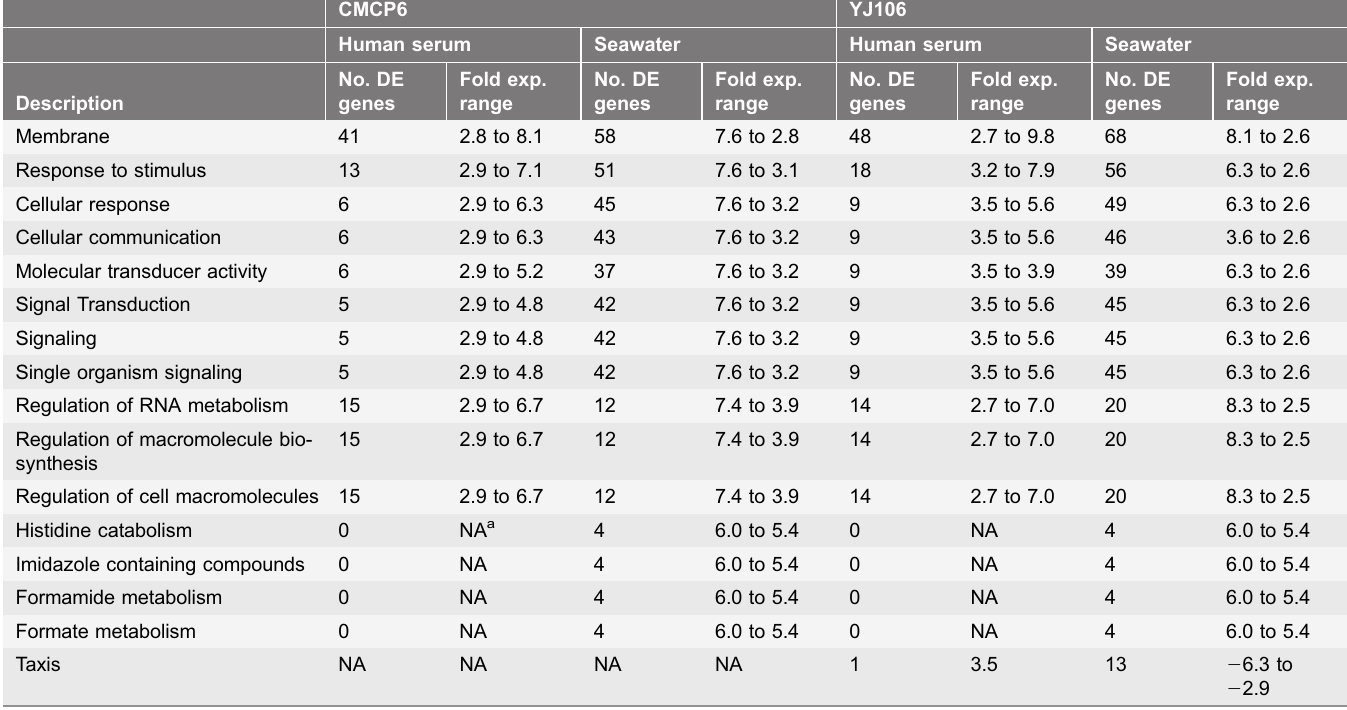
Table 2. Enriched Gene Ontology Categories of Differentially Expressed Genes in human serum and artificial seawater.